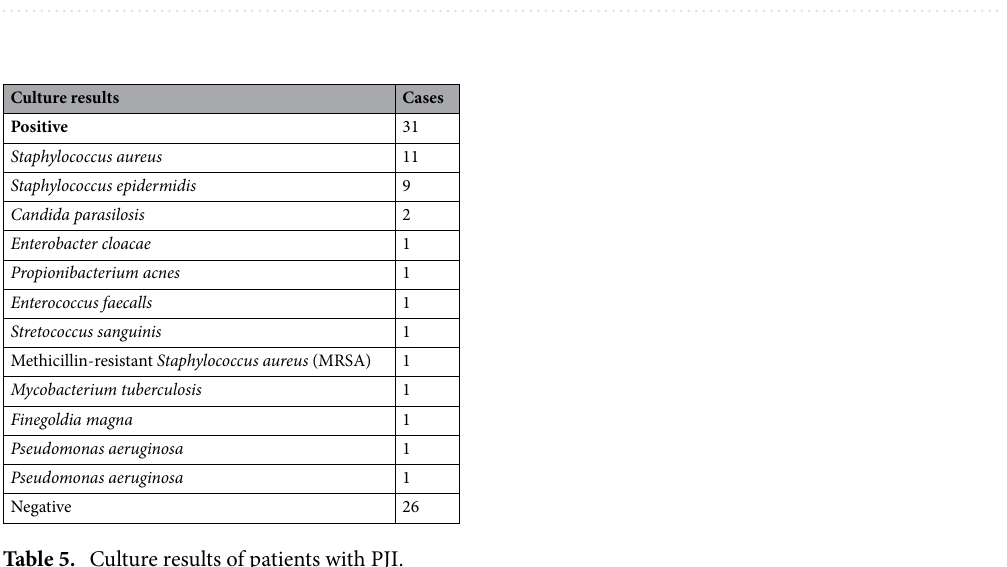
Table 4. The diagnosis values and threshold of plasma fibrinogen and ESR, CRP and serum WBC count for 156 cases.